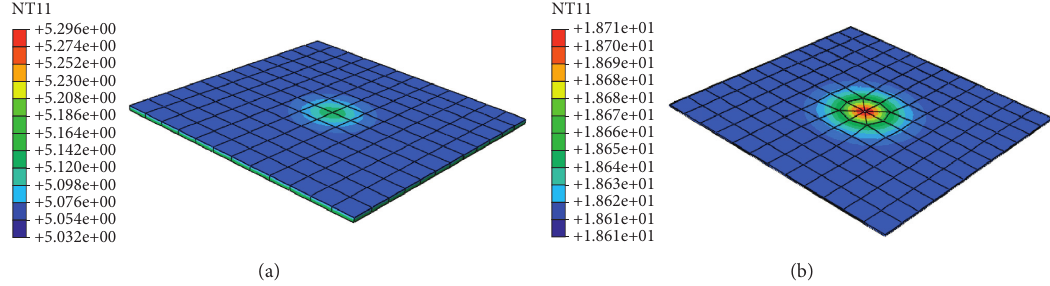
Figure 17: − 20 ° C temperature field of the semirigid finish layer (unit: ° C). (a) Bonding layer. (b) Interface